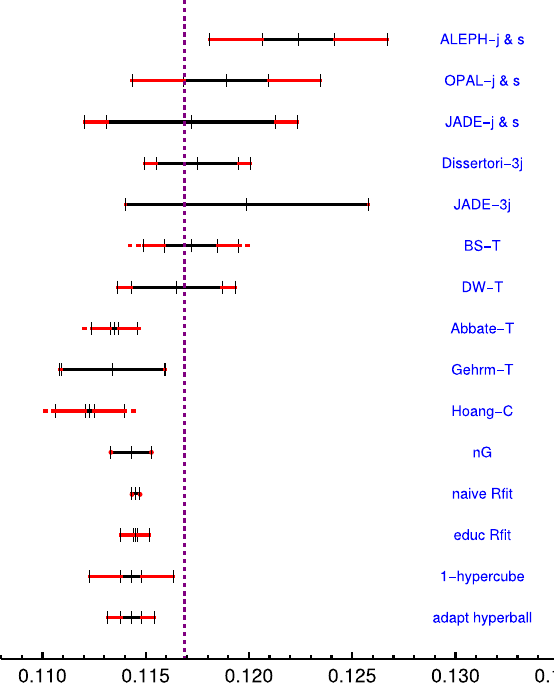
Fig. 8 Determinations of the strong coupling constant at M Z through e + e − annihilation, and the averages resulting from the different models considered here. The intervals are given at 1 σ . See Fig. 7 for the legend